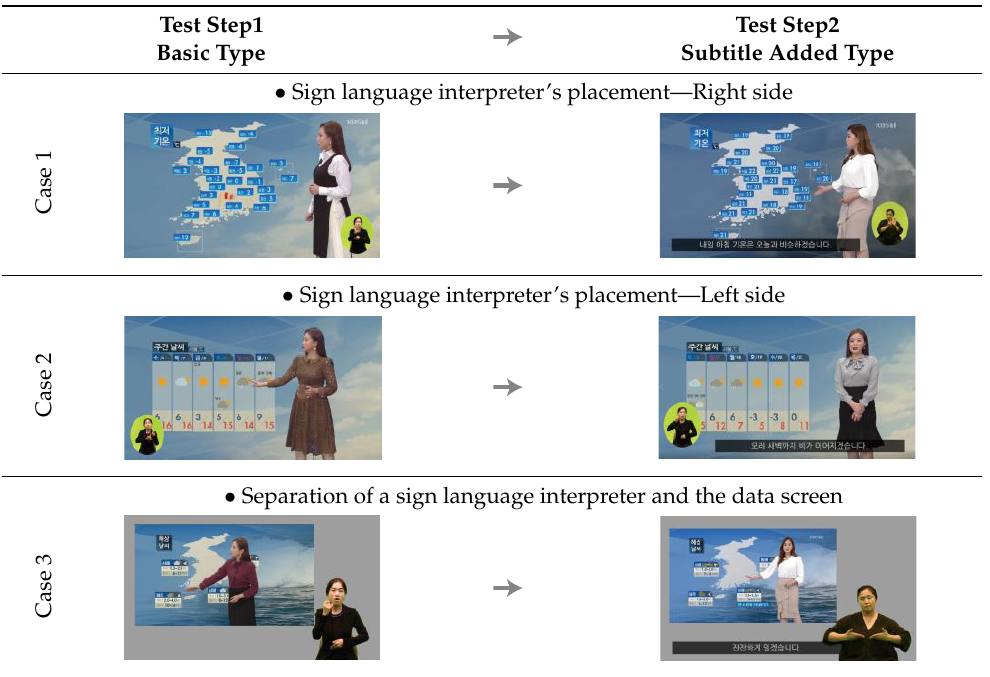
Table 2. Experiment design for news. Table 4. Experiment design for weather forecast types. Table 4. Experiment design for weather forecast types. Table 4. Experiment design for weather forecast types. Table 4. Experiment design for weather forecast types. Table 4. Experiment design for weather forecast types. Table 4. Experiment design for weather forecast types. Table 4. Experiment design for weather forecast types.